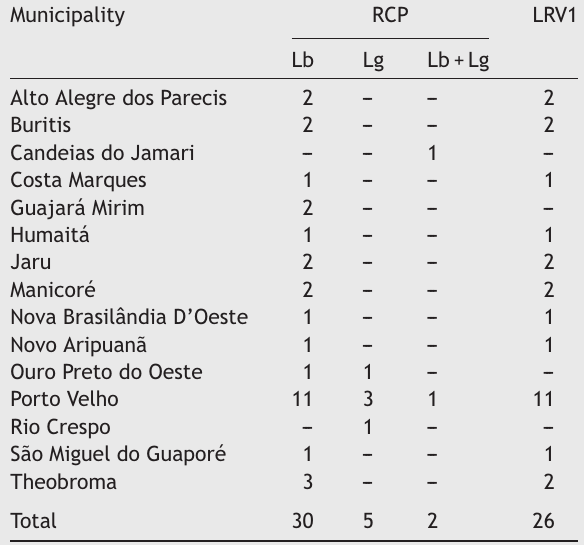
Figure 2 Main signs and symptoms presented by patients eval- uated in the survey.